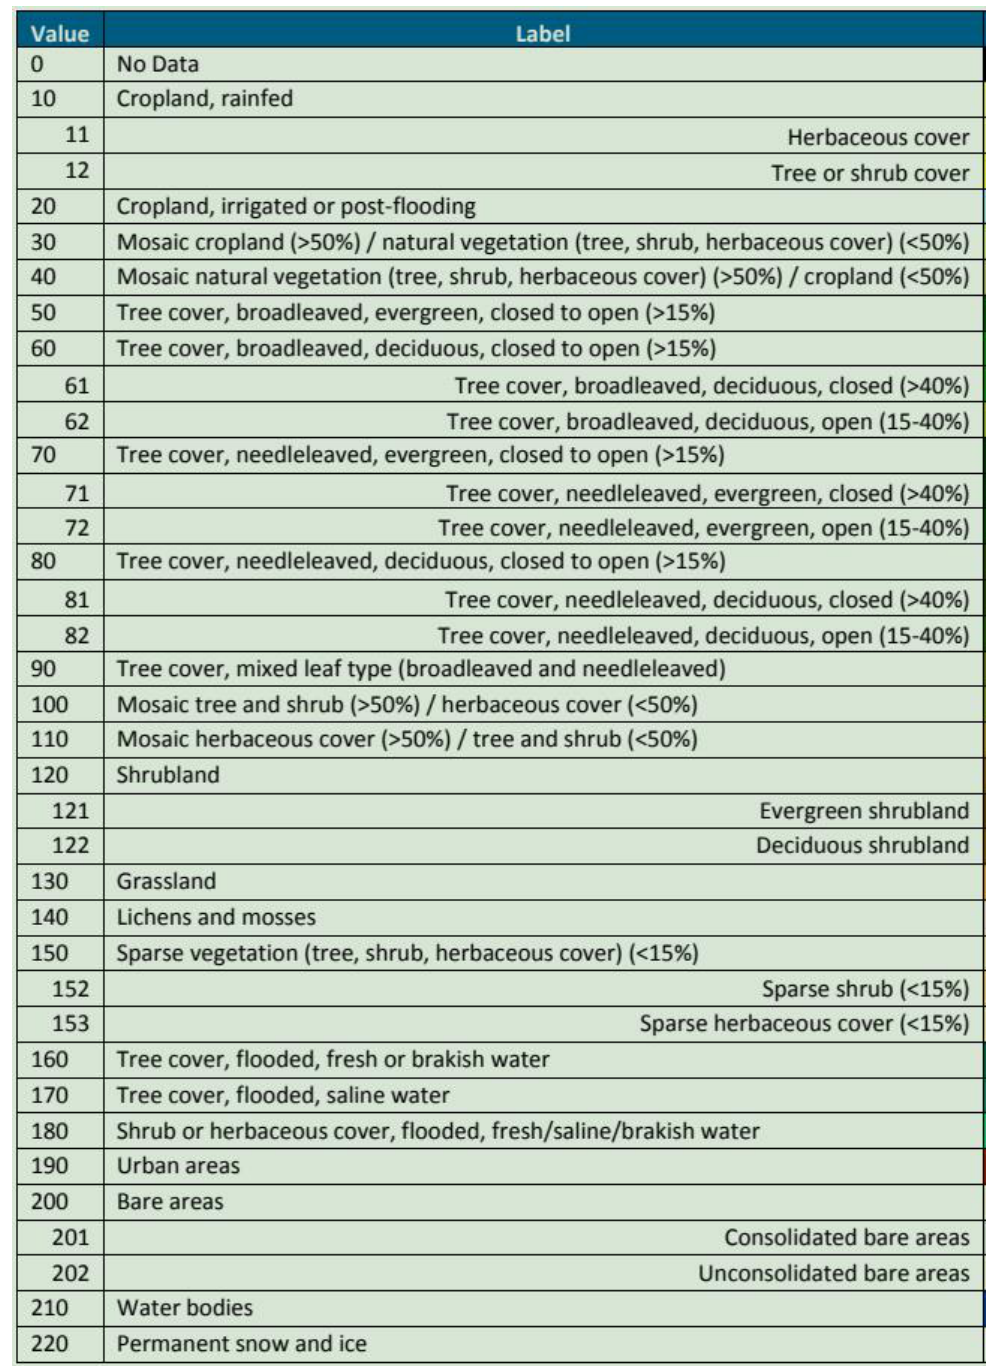
Figure A1. The classification standard for CCI land cover [58]. As the CCI-LC maps are designed to be globally consistent, their legend is determined by the level of information that is available and that makes sense at the scale of the entire world. The “level 1” legend (also called “global” legend) counts 22 classes and each class is associated with a 10-value code (i.e., class codes of 10, 20, 30, etc.). The CCI-LC maps are also described by a more detailed legend, called “level 2” or “regional”. This level 2 legend makes use of more accurate and regional information (where available). This regional legend has, therefore, more classes. The regional classes are associated with non-ten values (i.e., class codes such as 11, 12, etc.). They are not present all over the world since they were not properly discriminated at the global